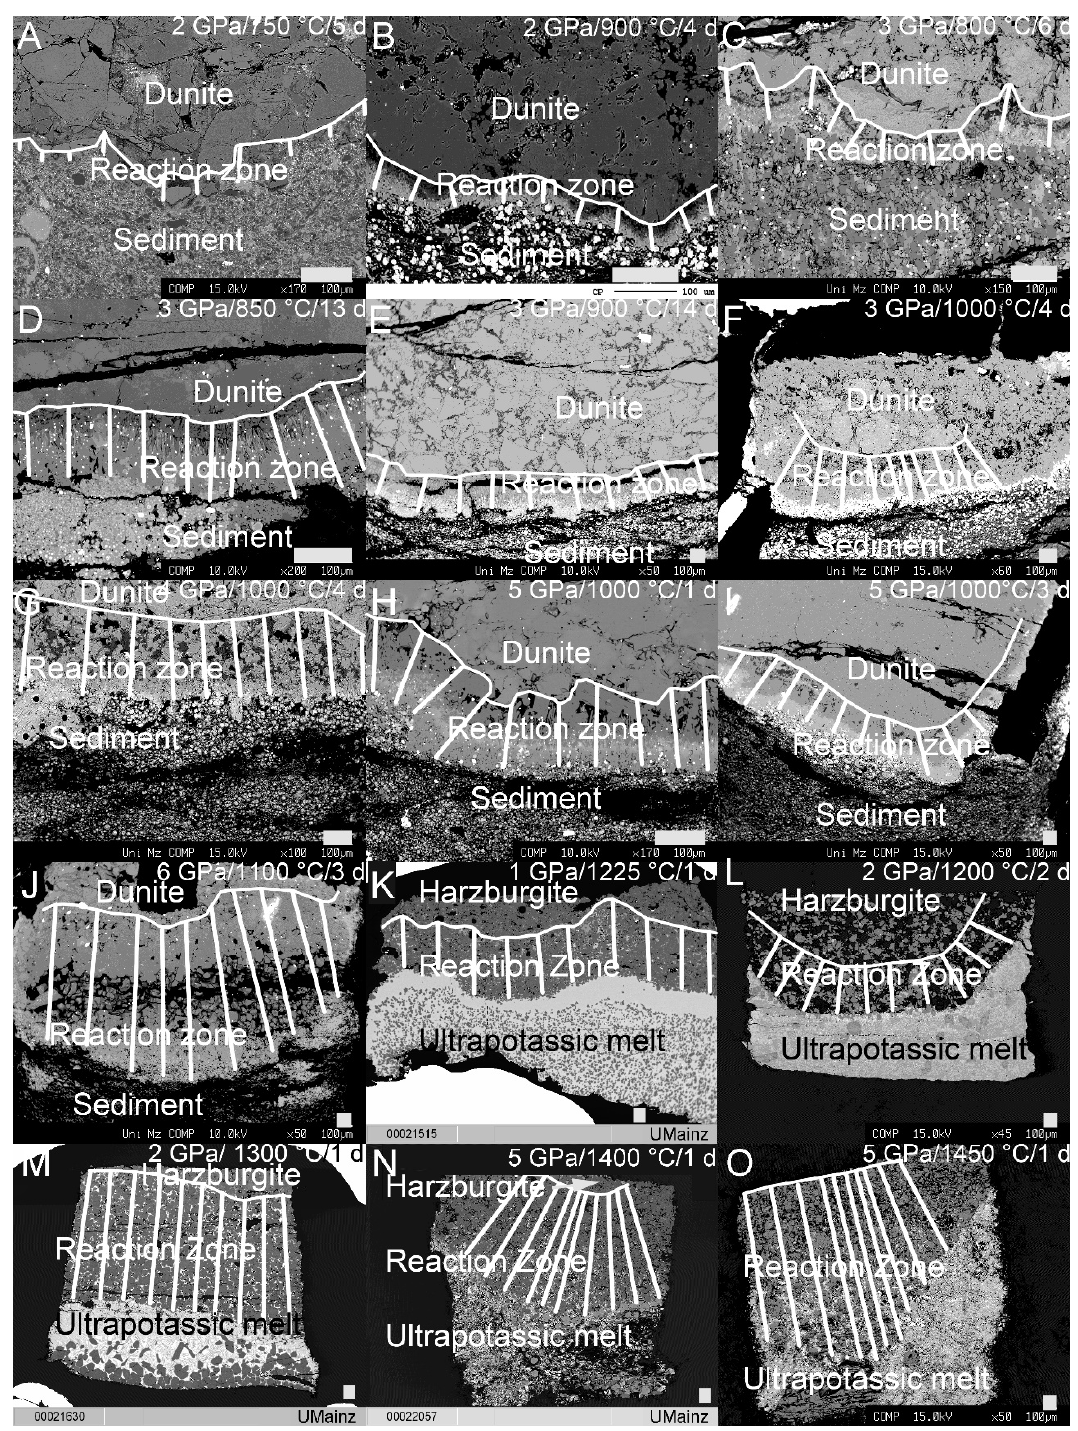
Figure A1. Metasome thicknesses and infiltrated melt distances in reaction experiments at 2 GPa ( A , B ), 3 GPa ( C – F ), 4 GPa ( G ), 5 GPa ( H , I ), and 6 GPa ( J ). Each reaction zone was measured 10 times (along white lines) to calculate the growth rate of the reaction zone (Table 1). Additional experiments using ultrapotassic melts at a similar pressure range of 1-5 GPa (last 5 images, [37,53]) show infiltration rates of 505 ± 60 µm/d ( K ), 371 ± 24 µm/d ( L ), 1039 ± 31 µm/d ( M ), 983 ± 44 µm/d ( N ), and 1127 ± 187 µm/d ( O ). Scale bar is 100 µm in every image.